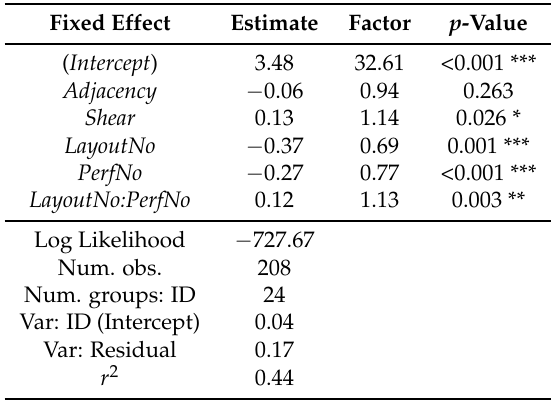
Figure 2. Inaccuracies, averaged across participants, for the scale training task. The higher the line, the more accurate the average performance. The bootstrapped confidence intervals cover a 95% range. Adjacent layouts have solid lines, nonadjacent have dashed lines. Sheared layouts have orange lines, unsheared have blue lines. The first performance is coded 0, the second is coded 1, ...; the first layout is coded 0, the second is coded 1. Table 1. Generalized linear mixed effects model for the scale training